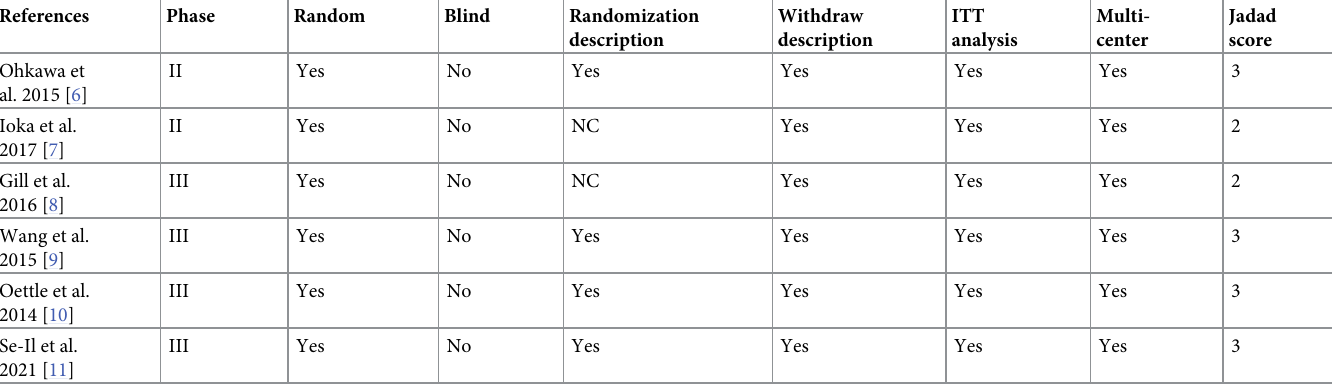
Table 4. Methodological details which might cause bias of included